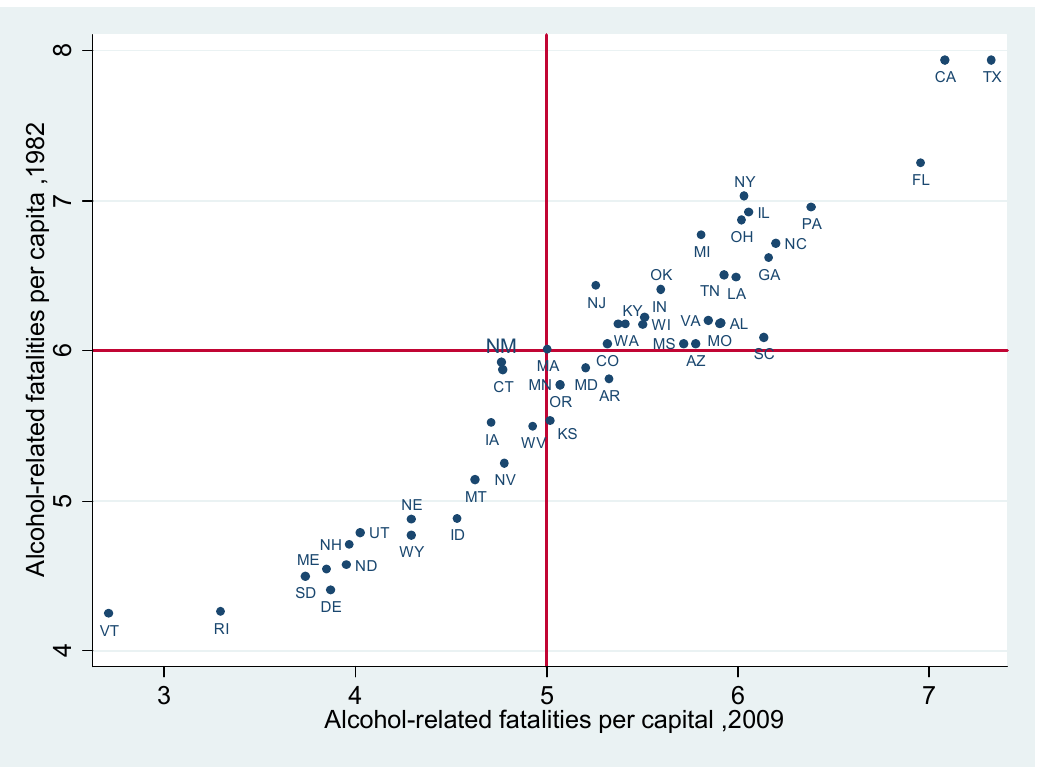
Figure 1. Alcohol-related fatalities in 2009 (horizontal axis) and 1982 (vertical axis).